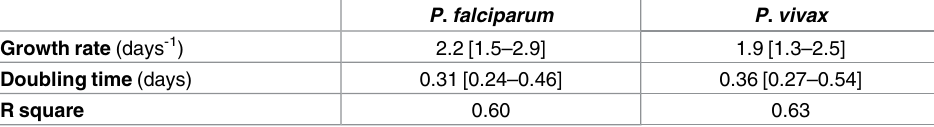
Table 1. Statistics of exponential growth equation fitting the parasitemia curves of P . falciparum and P . vivax infected na ï